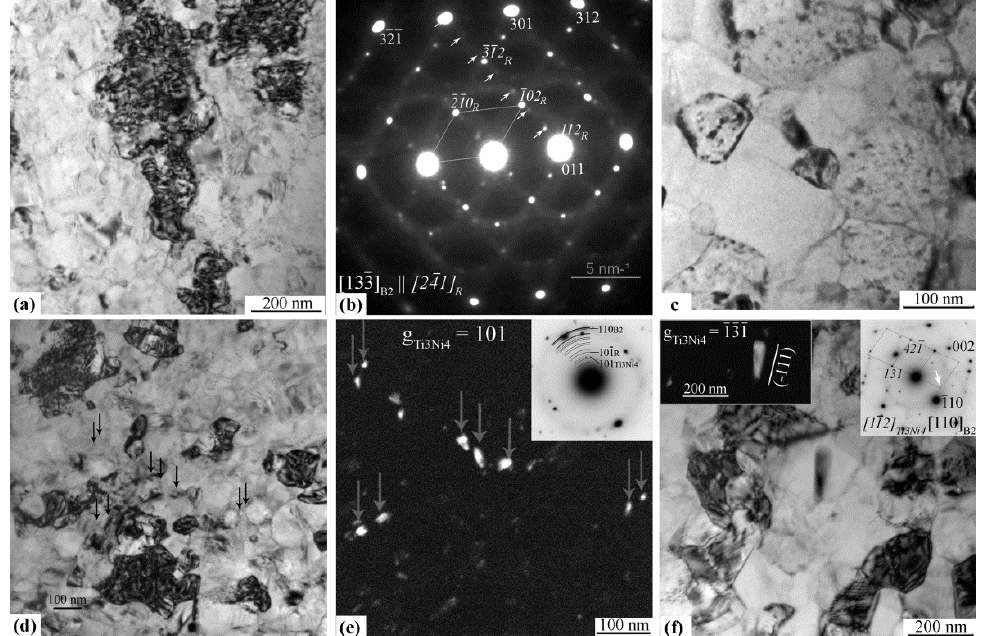
Figure 4. Typical structure of Ti-50.9Ni after annealing at 300 °C ( а – c ), 400 °C ( d , e ), and 500 °C ( f ): ( a ) BF of a substructure region; ( b ) corresponding SAED and zone axes Z B2 = [13 3̅ ] and Z R = [2 4̅ 1] parallel to the incident electron beam are indexed, dark arrows show reflections of Ti 3 Ni 4 particles in positions 1/7 along the B2 lattice directions [ 3̅ 21] B2 , and the R-phase reciprocal lattice section marked with lines; ( c ) BF of a nanograin region with contrast indicating the presence of coherent Ti 3 Ni 4 particles; ( d ) BF of substructure and ( e ) DF (magnified relative to Figure ( d )) taken in Ti 3 Ni 4 reflection {101}, arrows in the ( d ) and ( e ) indicate the same places, and solid and dashed arcs correspond to positions of R- and Ti 3 Ni 4 -phases reflections; ( f ) BF corresponding SAED pattern and DF image taken in Ti 3 Ni 4 reflection { 1̅ 3 1̅ } (marked with arrow) in inset.